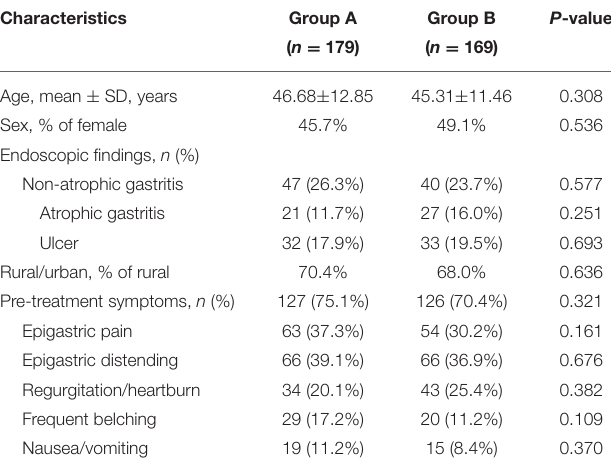
TABLE 1 | Baseline characteristics of all patients.